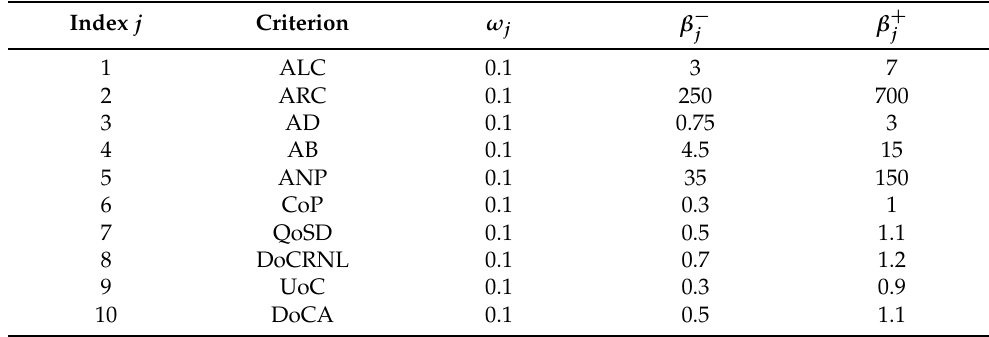
Table 15. Criteria importance weights and discordance